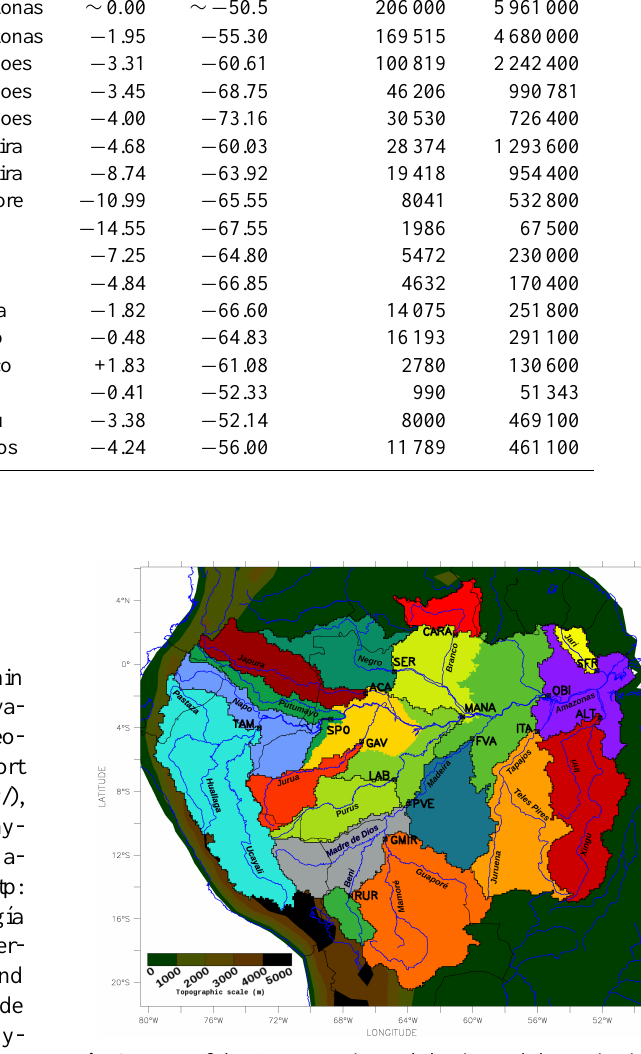
Table 2. List of ORE HYBAM gauge stations over the Amazon River basin. Except for the streamflow at the river mouth (1972–2003), the mean annual discharge ( Q mean ) corresponds to the mean annual value of ORE HYBAM data for the mean time period 1980–2000. Station Abbreviation River Latitude Longitude Q mean (m 3 s − 1 ) Area (km 2 ) Mouth (Callede et al., 2010) AMAZ Amazonas ∼ 0 . 00 ´Obidos OBI Amazonas